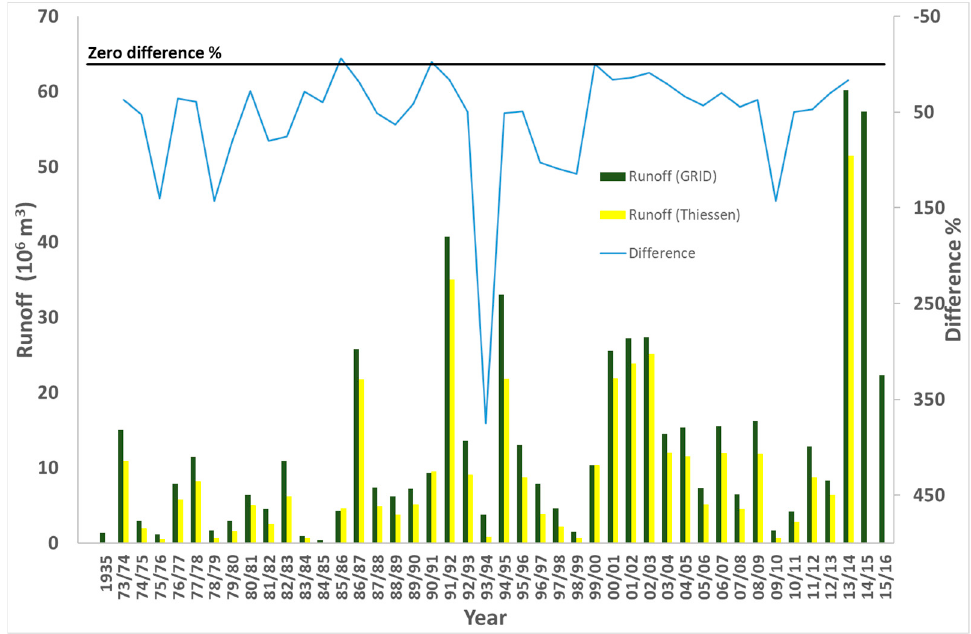
Figure 7. Runoff comparison between Thiessen polygon and GIS GRID methods with yearly difference.